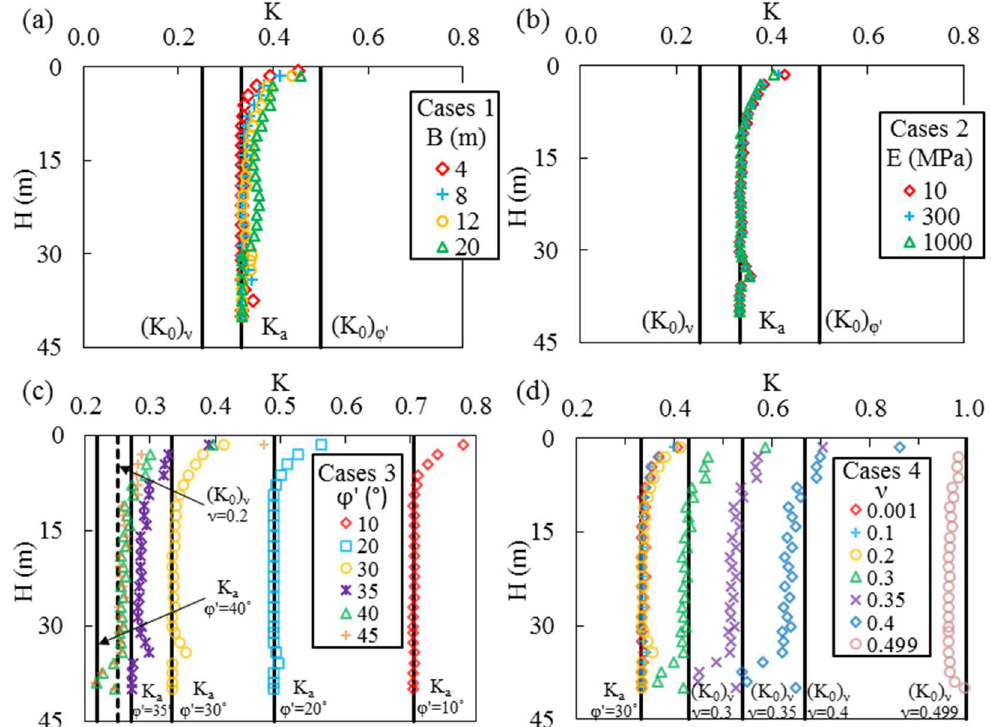
Figure 3. Distribution of K along the VCL of backfilled openings as a function of: ( a ) B (Cases 1); ( b ) E (Cases 2); ( c ) ϕ’ (Cases 3); and ( d ) ν (Cases 4) (see Table 1 for details).